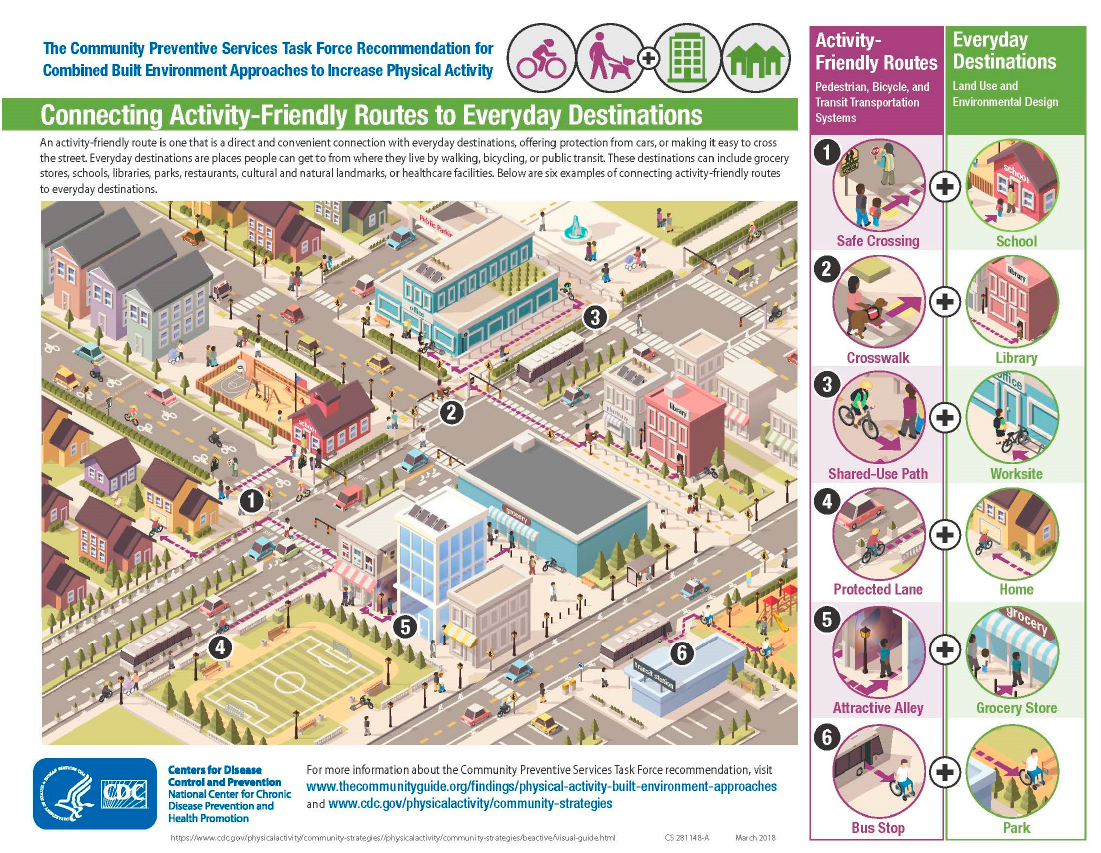
Figure 1. Connecting activity-friendly routes to everyday destinations. Image courtesy of Centers for Disease Control and Prevention (CDC) [7].